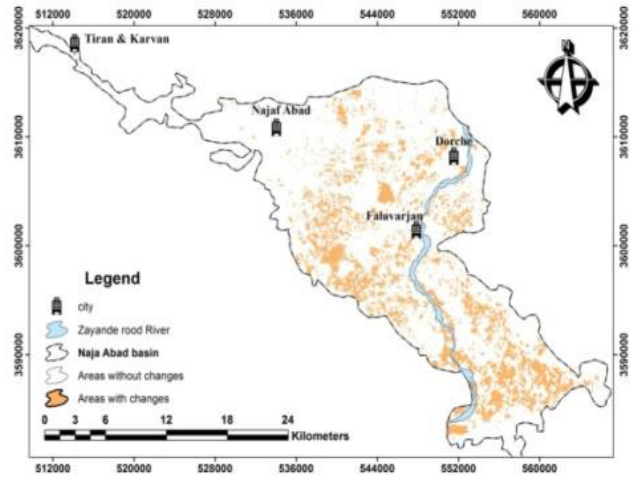
Figure 5. Zoning of unchanged pixels and changes pixel between 1995 to